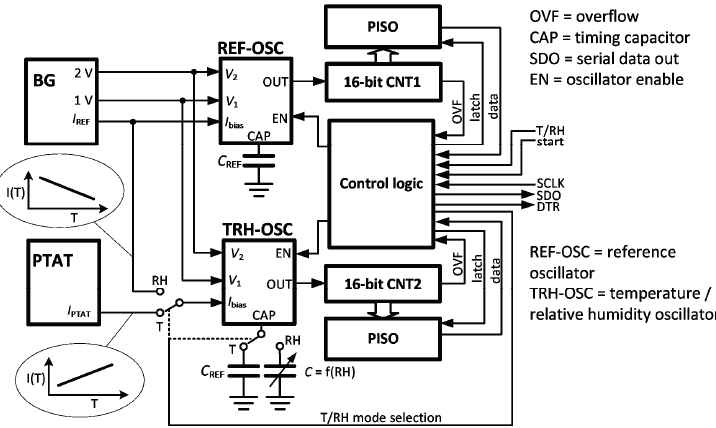
Figure 1. Architecture of the combined temperature and humidity sensor. Depending on the measurement mode, one of the counters (CNT1 or CNT2) defines the reference period for the other counter. BG, bandgap circuit; REF-OSC, reference oscillator; T/RH, temperature/relative humidity; PTAT, proportional to absolute temperature; PISO, parallel-in/serial-out; DTR, data ready; SCLK, serial